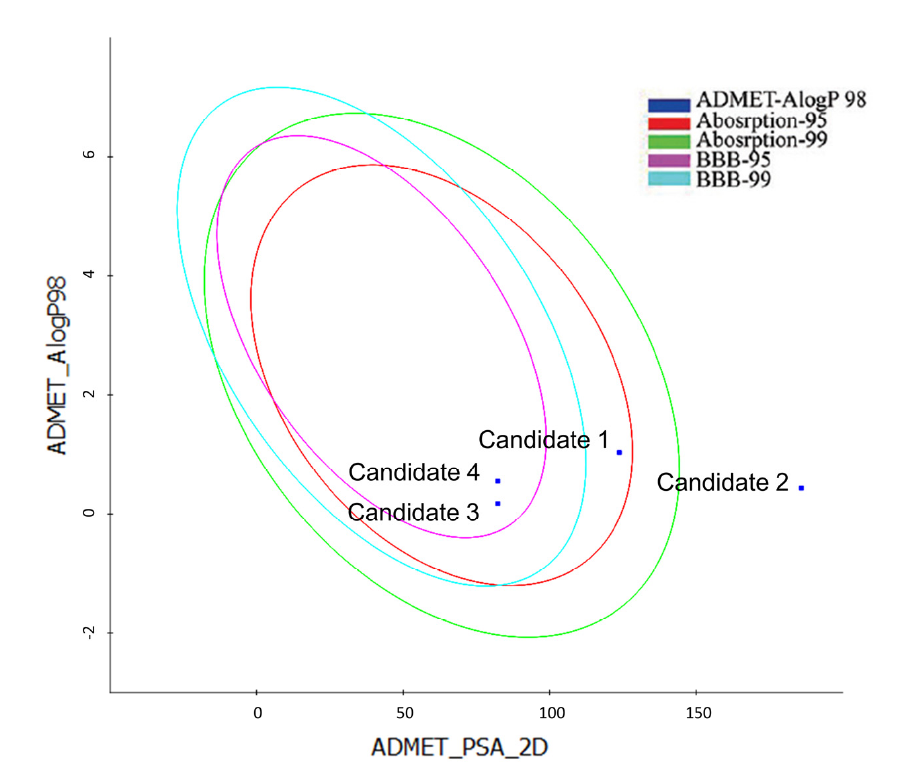
Figure 13. ADMET PSA vs. ALogP98 plot for identified compounds demonstrating the 95% and 99% confidence limit ellipses corresponding to the BBB and HIA models. According to the model, the compound should meet the following specifications to achieve optimal cellular permeability: PSA_2D < 140 Å 2 and AlogP98 < 5. ADMET: Absorption, distribution, metabolism, excretion, and toxicity, BBB: Blood–brain